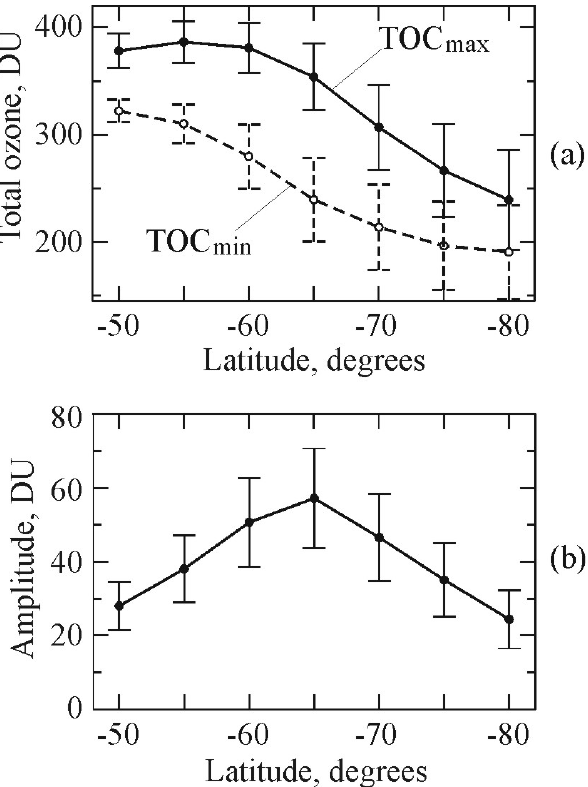
Fig. 3. (a) Mean total ozone at the zonal wave extremes and (b) mean amplitude of zonal wave in total ozone at the seven latitudes with 5-degree step between 50 ◦ S and 80 ◦ S over the 24 springs of